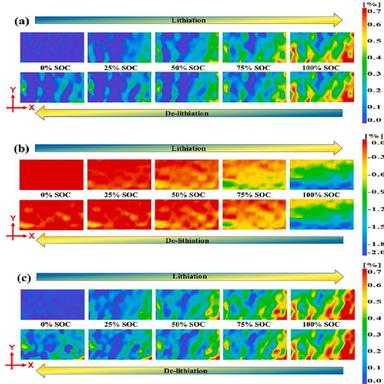
The evolution maps of (a) ԑxx, (b) ԑyy and (c) ԑp in the SnO2@graphite@CNT electrodes under different SOCs during the first discharging-charging cycle.